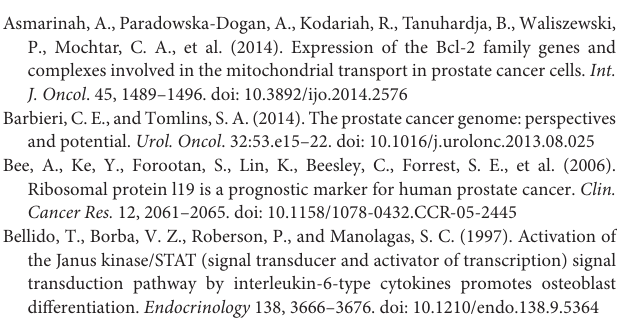
Supplemental Figure 3 | Ingenuity pathway interaction network of Wnt/GSK-3 β signaling. Differentially expressed genes between 20 week old dorsolateral prostate of TRAMP mice exhibiting alterations in elements of Wnt/GSK-3 β signaling pathway compared to age-matched non-transgenic littermates. Supplemental Figure 4 | Ingenuity pathway interaction network analysis of Glucocorticoid receptor signaling pathway. Differentially expressed genes between 20 week old dorsolateral prostate of TRAMP mice exhibiting alterations in elements of Glucocorticoid receptor signaling pathway compared to age-matched non-transgenic littermates. Supplemental Figure 5 | Ingenuity pathway interaction network analysis of role of Immune cell signaling. Differentially expressed genes between 20 week old dorsolateral prostate of TRAMP mice exhibiting alterations in role of macrophage and other immune cells compared to age-matched non-transgenic littermates. Supplemental Figure 6 | Ingenuity pathway interaction network analysis of Gas signaling pathway. Differentially expressed genes between 20 week old dorsolateral prostate of TRAMP mice exhibiting alterations in elements of Gas signaling pathway compared to age-matched non-transgenic littermates. Supplemental Figure 7 | Ingenuity pathway interaction network analysis of iNOS signaling pathway. Differentially expressed genes between 20 week old dorsolateral prostate of TRAMP mice exhibiting alterations in elements of iNOS signaling pathway compared to age-matched non-transgenic littermates. Supplemental Figure 8 | Ingenuity pathway interaction network analysis of hypoxia signaling pathway. Differentially expressed genes between 20 week old dorsolateral prostate of TRAMP mice exhibiting alterations in elements of hypoxia signaling pathway compared to age-matched non-transgenic littermates. Supplemental Figure 9 | Ingenuity pathway interaction network analysis of Wnt/ β -catenin signaling pathway. Differentially expressed genes between 20 week old dorsolateral prostate of TRAMP mice exhibiting alterations in elements of Wnt/ β -catenin signaling pathway compared to age-matched non-transgenic littermates. Supplemental Figure 10 | Ingenuity pathway interaction network analysis of Cancer metastasis signaling pathway. Differentially expressed genes between 20 week old dorsolateral prostate of TRAMP mice exhibiting alterations in elements of metastasis signaling pathway compared to age-matched non-transgenic littermates. Supplemental Figure 11 | Ingenuity pathway interaction network analysis of p38MAPKsignaling pathway. Differentially expressed genes between 20 week old dorsolateral prostate of TRAMP mice exhibiting alterations in elements of p38MAPKsignaling pathway compared to age-matched non-transgenic littermates. Supplementary Figure 12 | Ingenuity pathway interaction network analysis of oxidative phosphorylation signaling pathway. Differentially expressed genes between 20 week old dorsolateral prostate of TRAMP mice exhibiting alterations in elements of oxidative phosphorylation signaling pathway compared to age-matched non-transgenic littermates. Supplemental Table 1 | List of set of primers of qRT-PCR with sequence (forward and reverse) used in the experiment to validate microarray